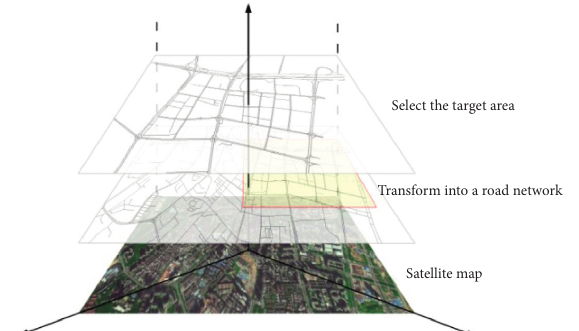
Figure 10: Selection of research area.